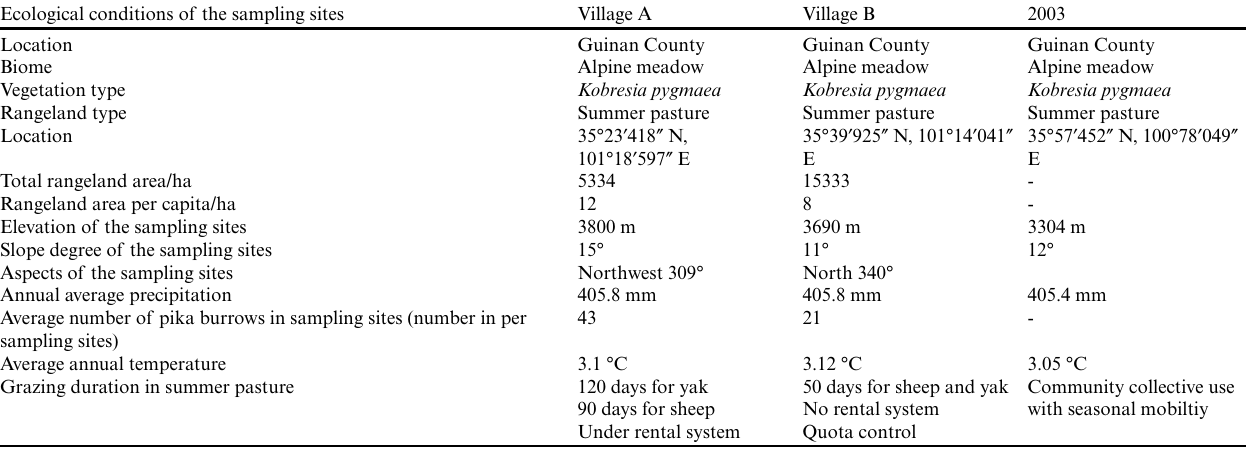
Table 2 . Ecological conditions of the sampling sites in the summer pastures of the two villages and the 2003 study site by Yang (Yang